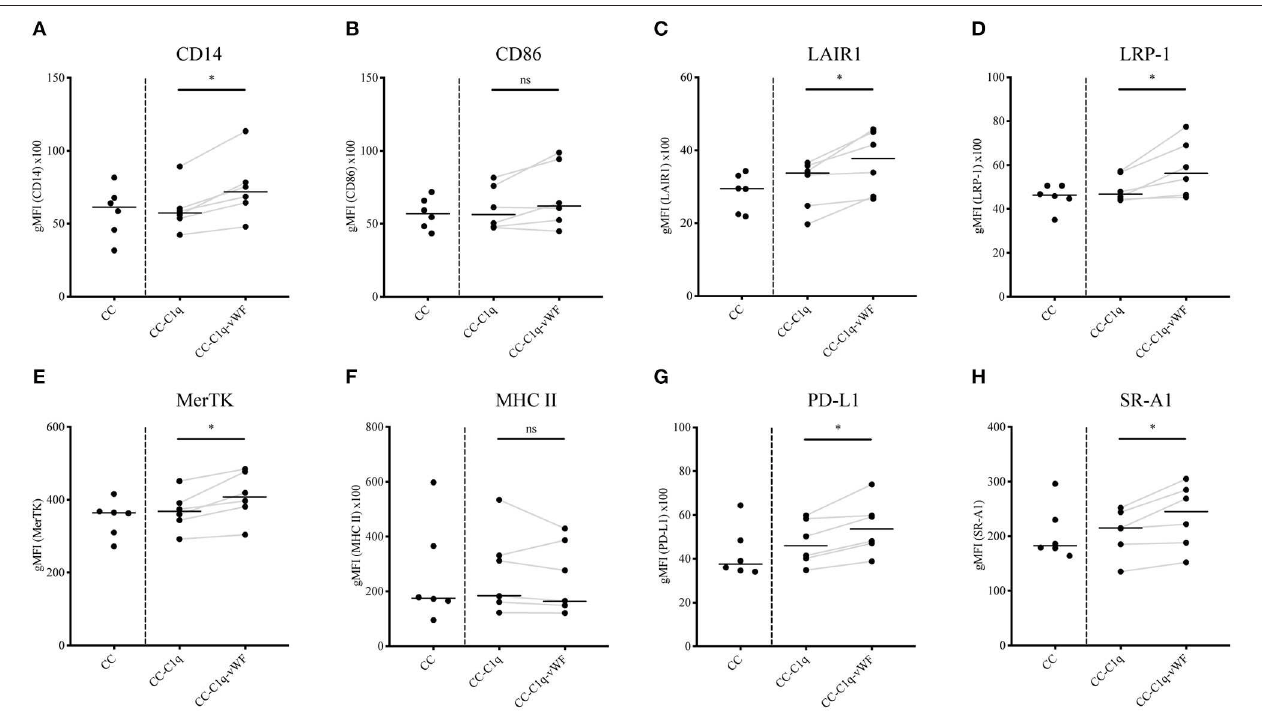
FIGURE 2 | CC-C1q-vWF complexes upregulate the surface receptor expression of HMDMs. LPS-stimulated HMDMs were treated with CC, CC-C1q or CC-C1q-vWF complexes for 18h and analyzed by flow cytometry for surface marker expression of (A) CD14, (B) CD86, (C) LAIR1, (D) LRP-1, (E) MerTK, (F) MHC II, (G) PD-L1, and (H) SR-A1. Pooled flow cytometry data are shown as gMFI with horizontal lines denoting median. Data points represent independent experiments analyzing six different healthy donors used to obtain HMDMs (Wilcoxon matched pairs signed rank test, * p < 0.05; ns, not significant).